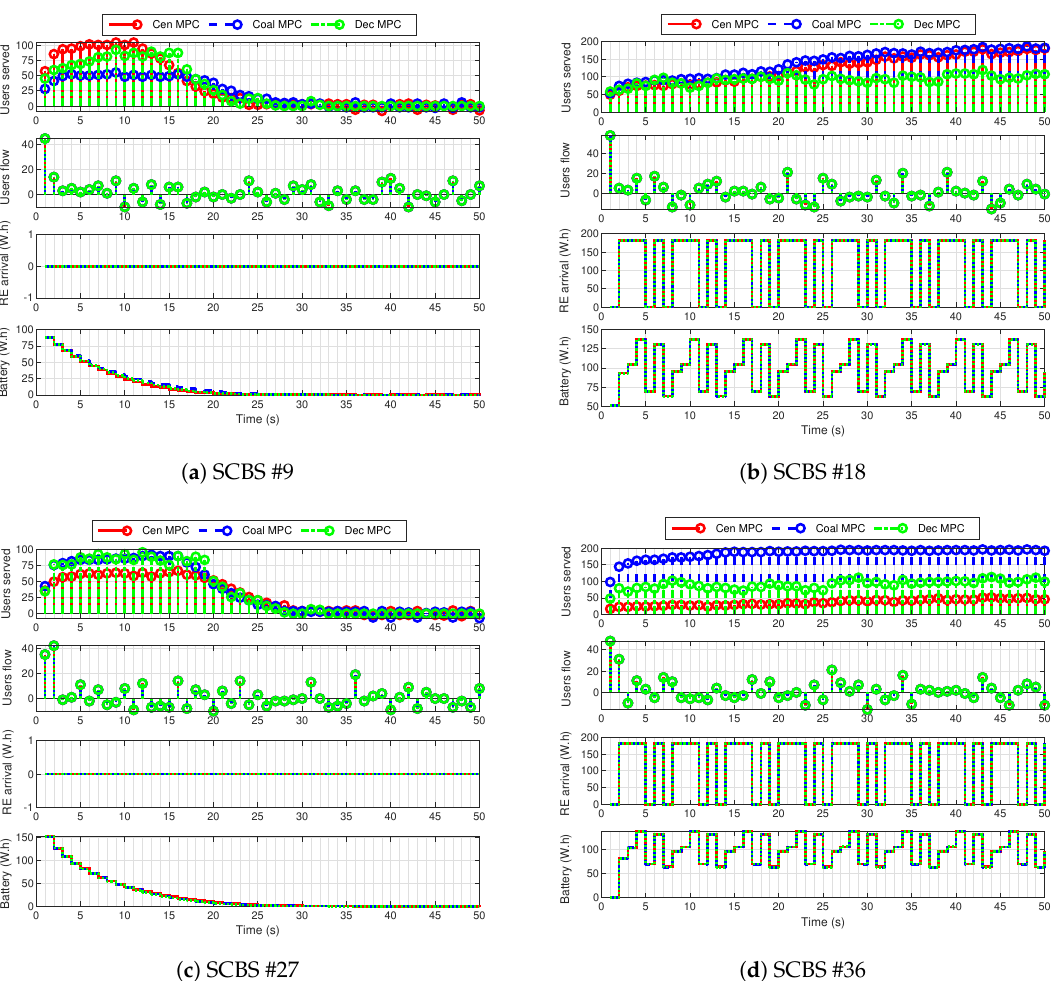
Figure 8. Comparison of several SCBSs from the 37-BS network. In each subfigure, the first row represents the user served by the SCBS; the second one is the user flow expected; the third row depicts the renewable energy arrival; and the fourth one show the energy stored in the